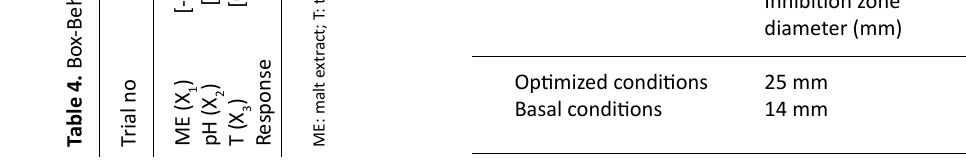
Table 5. Verification experiment showing antimicrobial activity of A. terreus SHE05 against A. hydrophila grown under the optimized conditions in comparison with the basal